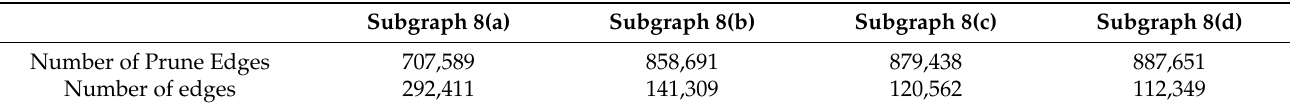
Table 2. The number of edges with different values of τ 1 and τ 2 .